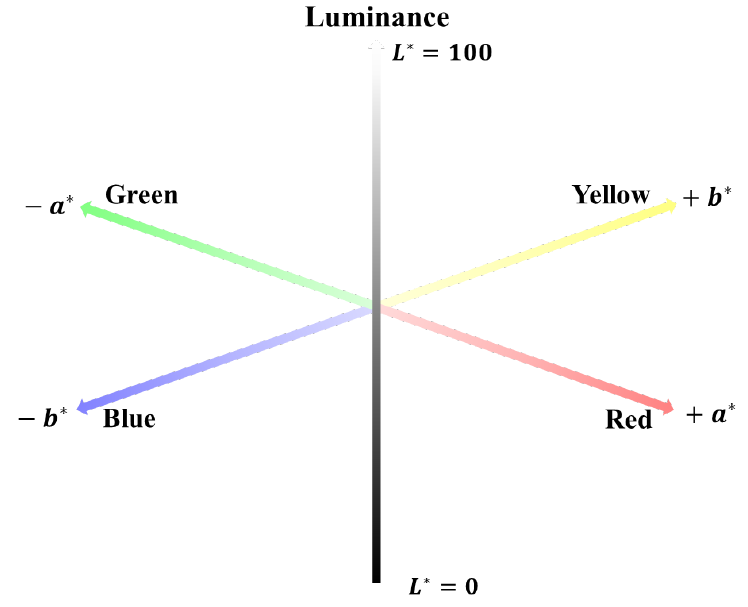
Figure 2. Three-dimensional CIELAB color